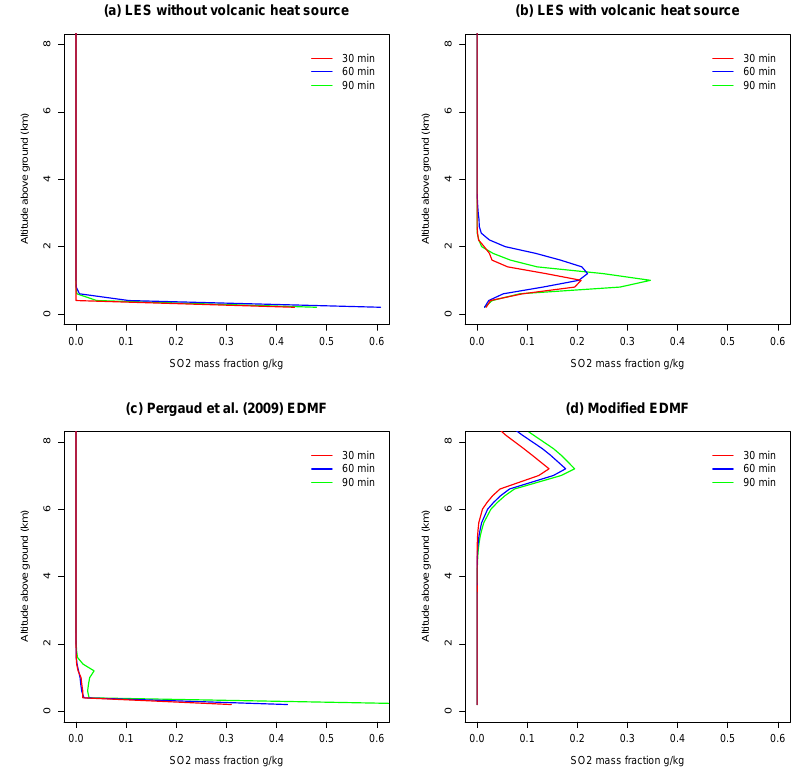
Figure 6. (a) and (b) : vertical profiles of SO 2 tracer mass fractions (gkg − 1 ) horizontally averaged over the 1km × 1km domain of LES simulations. (c) and (d) : vertical profiles of SO 2 mass fractions in the central grid cell (1km × 1km) of the SCM simulations. All simulations were inputted with the same SO 2 surface mass flux. Colour code for all panels: red – 30min, blue – 60min, and green – 90min after model